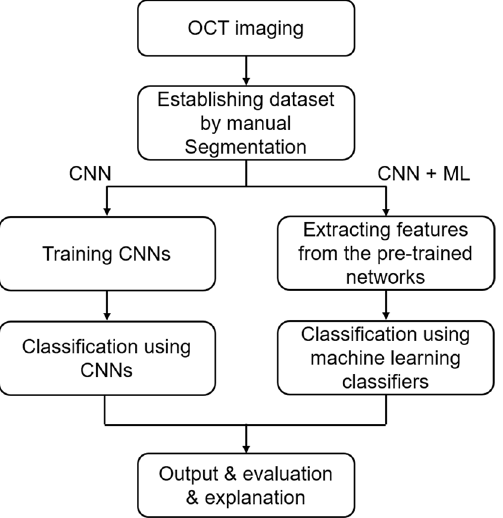
Figure 2. Flowchart of the oral tissue classification experiment.